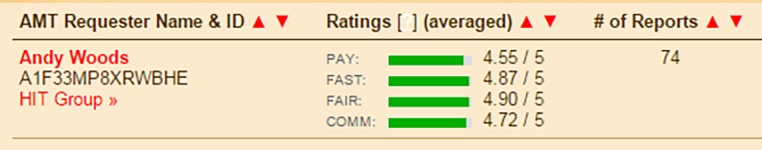
An example TurkOpticon requester profile (74 MTurkers having provided feedback on the requester).